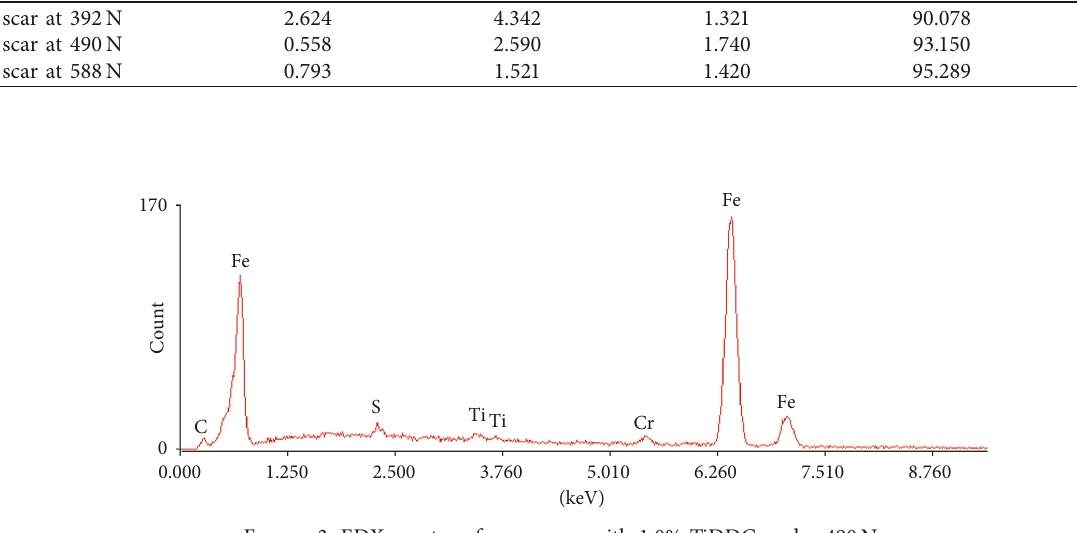
Figure 3: EDX spectra of wear scars with 1.0% TiDDC under